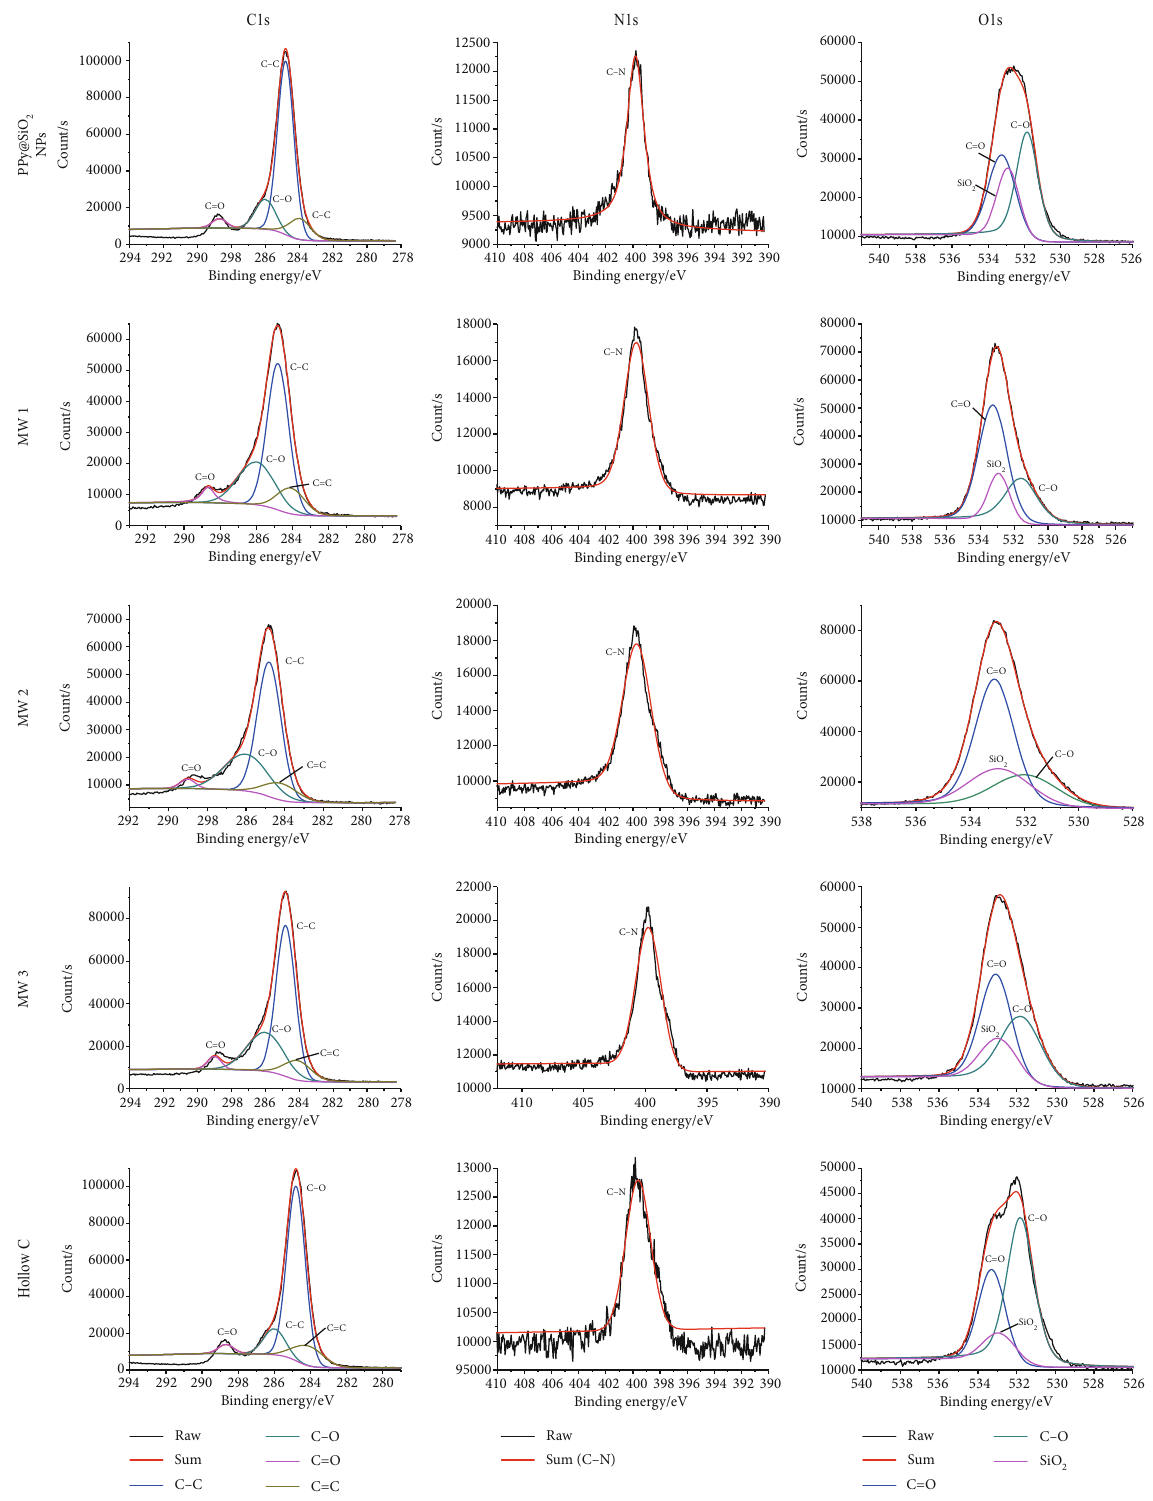
Figure 6: XPS spectra of each group in C1s, N1s, and